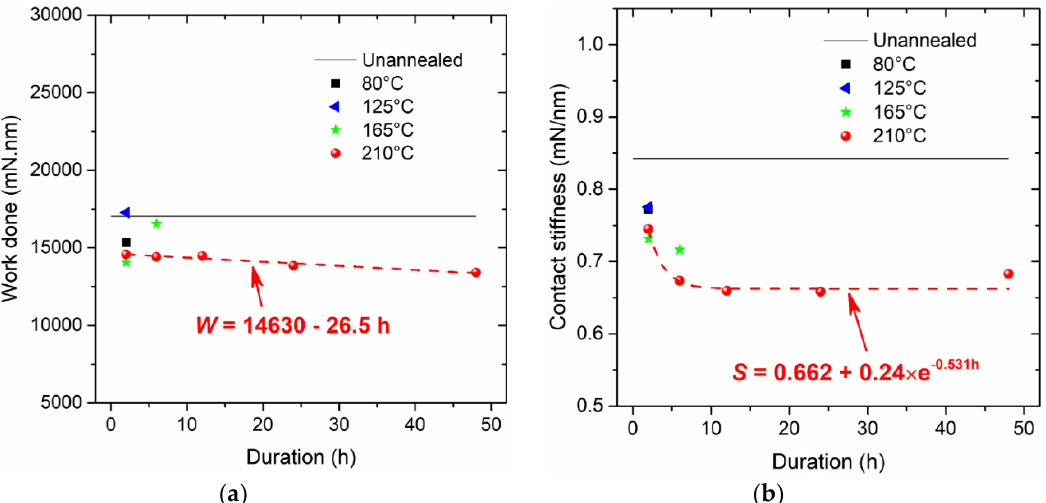
Figure 7. Determined properties from nanoindentation responses: ( a ) contact stiffness during the unloading stage, and ( b ) work done during the loading stage.